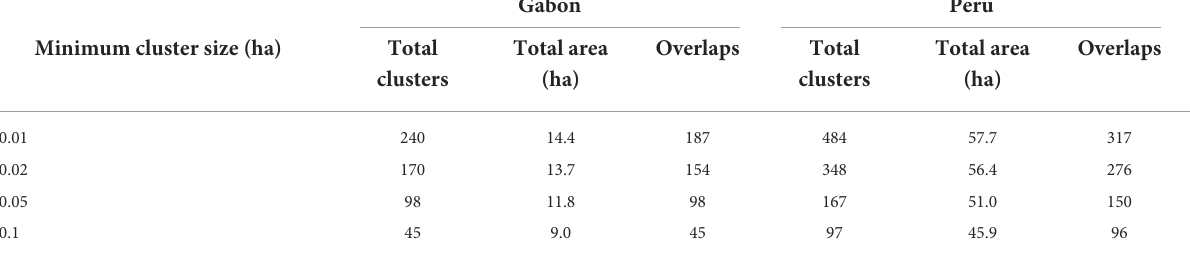
TABLE 4 Results from the CuSum change detection algorithm showing total number of disturbance clusters, total disturbance area, and total number of overlaps with respect to the LiDAR reference map (Gabon: 317 LiDAR clusters for a total area of 18.0 ha; Peru: 689 LiDAR clusters for a total area of 84.8 ha).